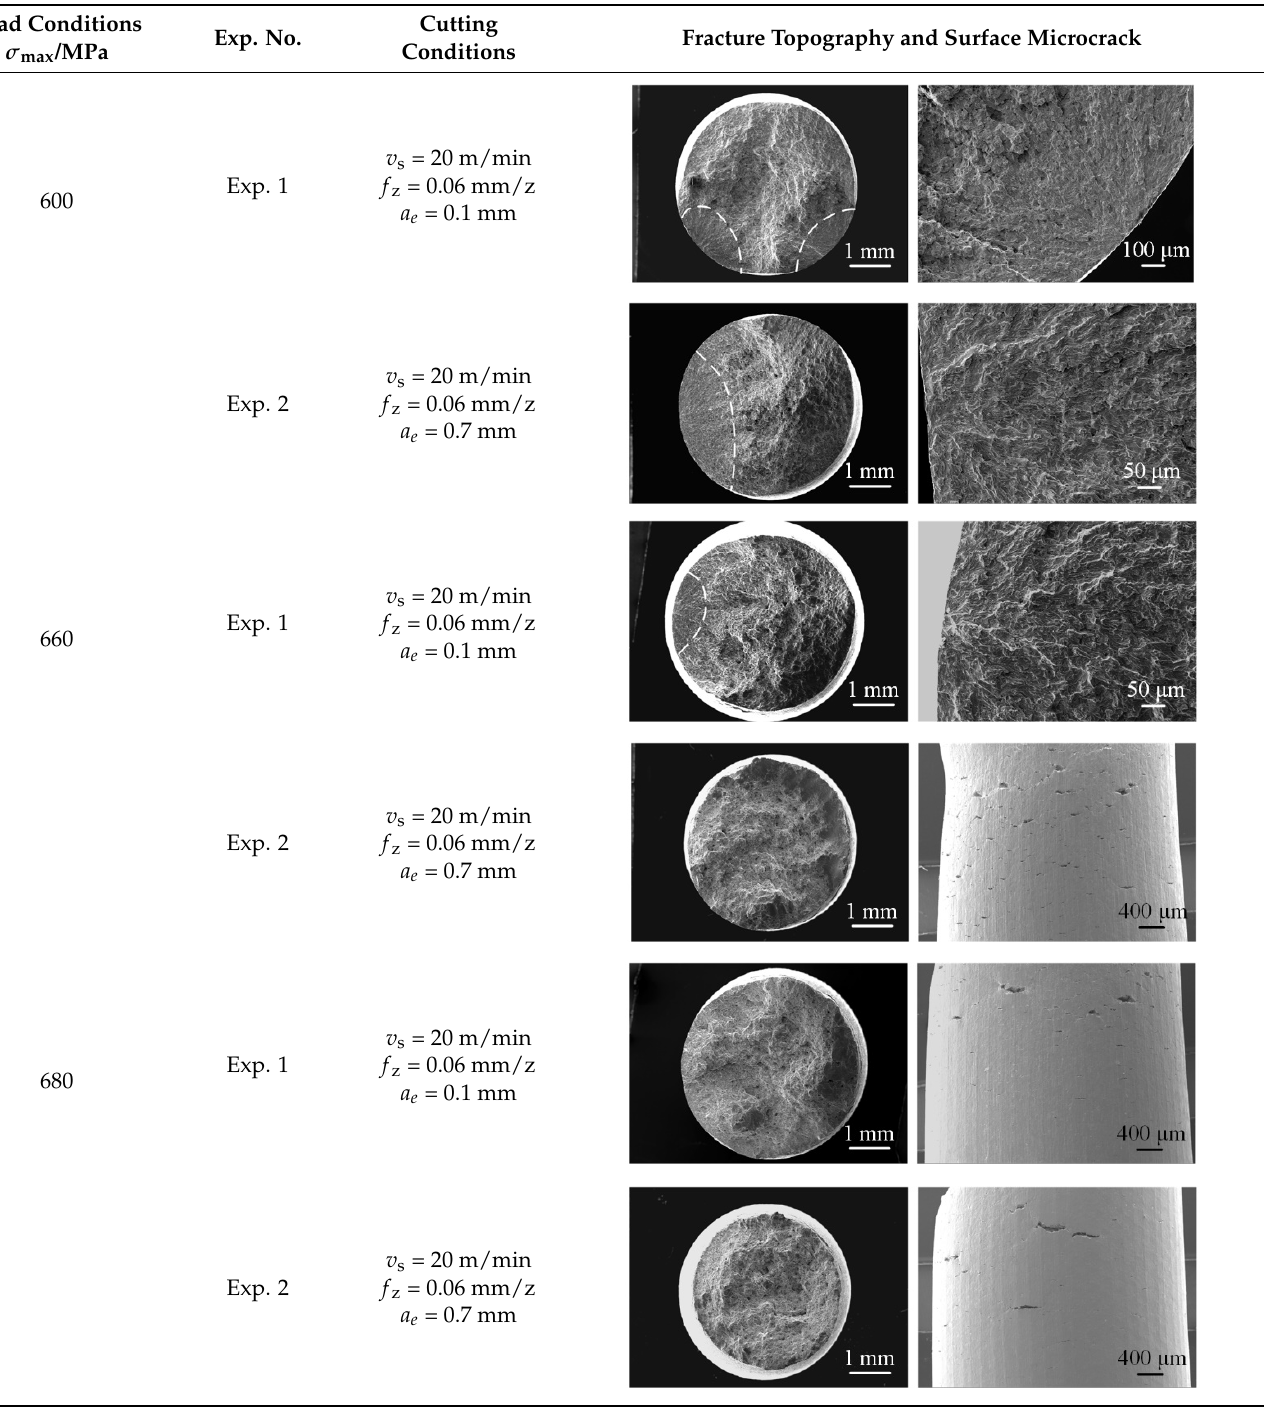
Table 8. Fracture topography and microscopic surface of 20Cr specimens.